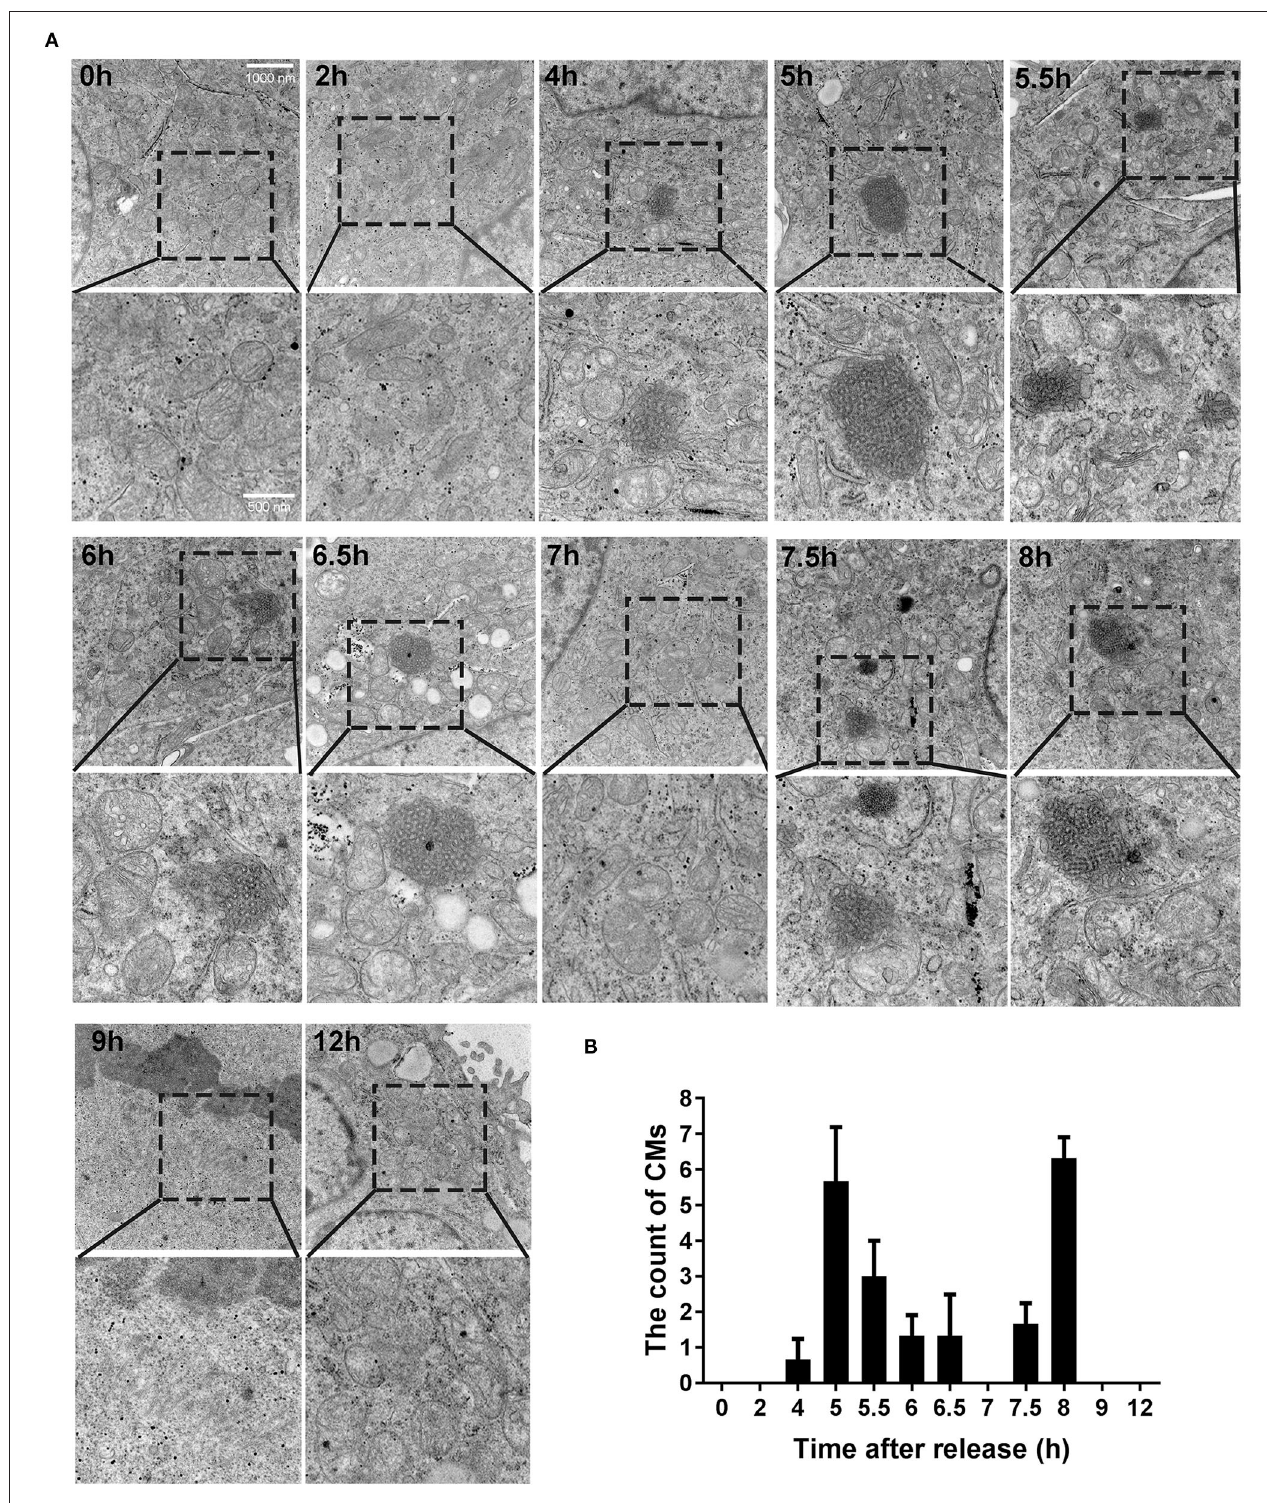
FIGURE 3 | CMs appeared in G2 phase of cell cycle. (A) Ultrastructural observations of cells at indicated time points after releasing from S phase. Representative images (20500X magnification) by transmission electron microscope were shown and the enlarged images in the rectangular area were placed below, respectively. (B) Statistics of CMs in every 100 cells at indicated time points. All values were denoted as the means ± SD; N = 3.